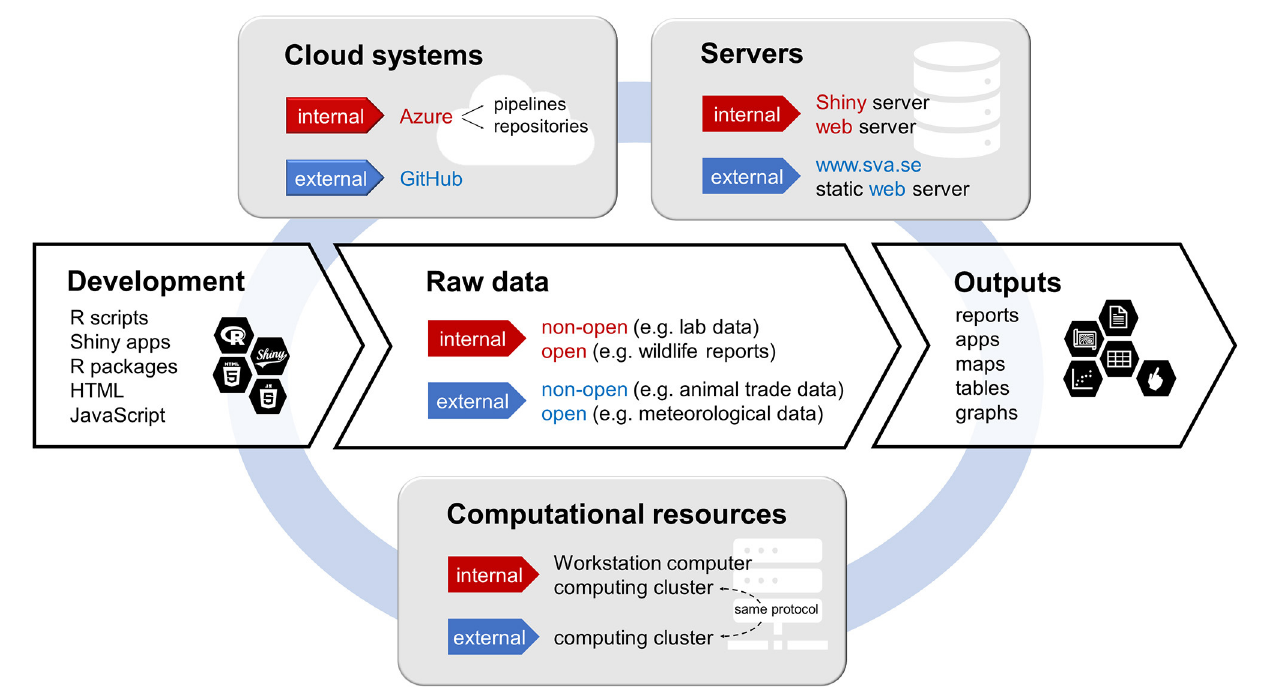
FIGURE1 Schematic representation of the components of the described collaborative environment for data analyses. The main workflow from development to output (white background) operates through several supporting infrastructures (gray background). The supporting systems marked as “internal” are accessible by SVA only while “external” systems are publicly available. For the raw data, the distinction between internal and external instead refers to the data origin and